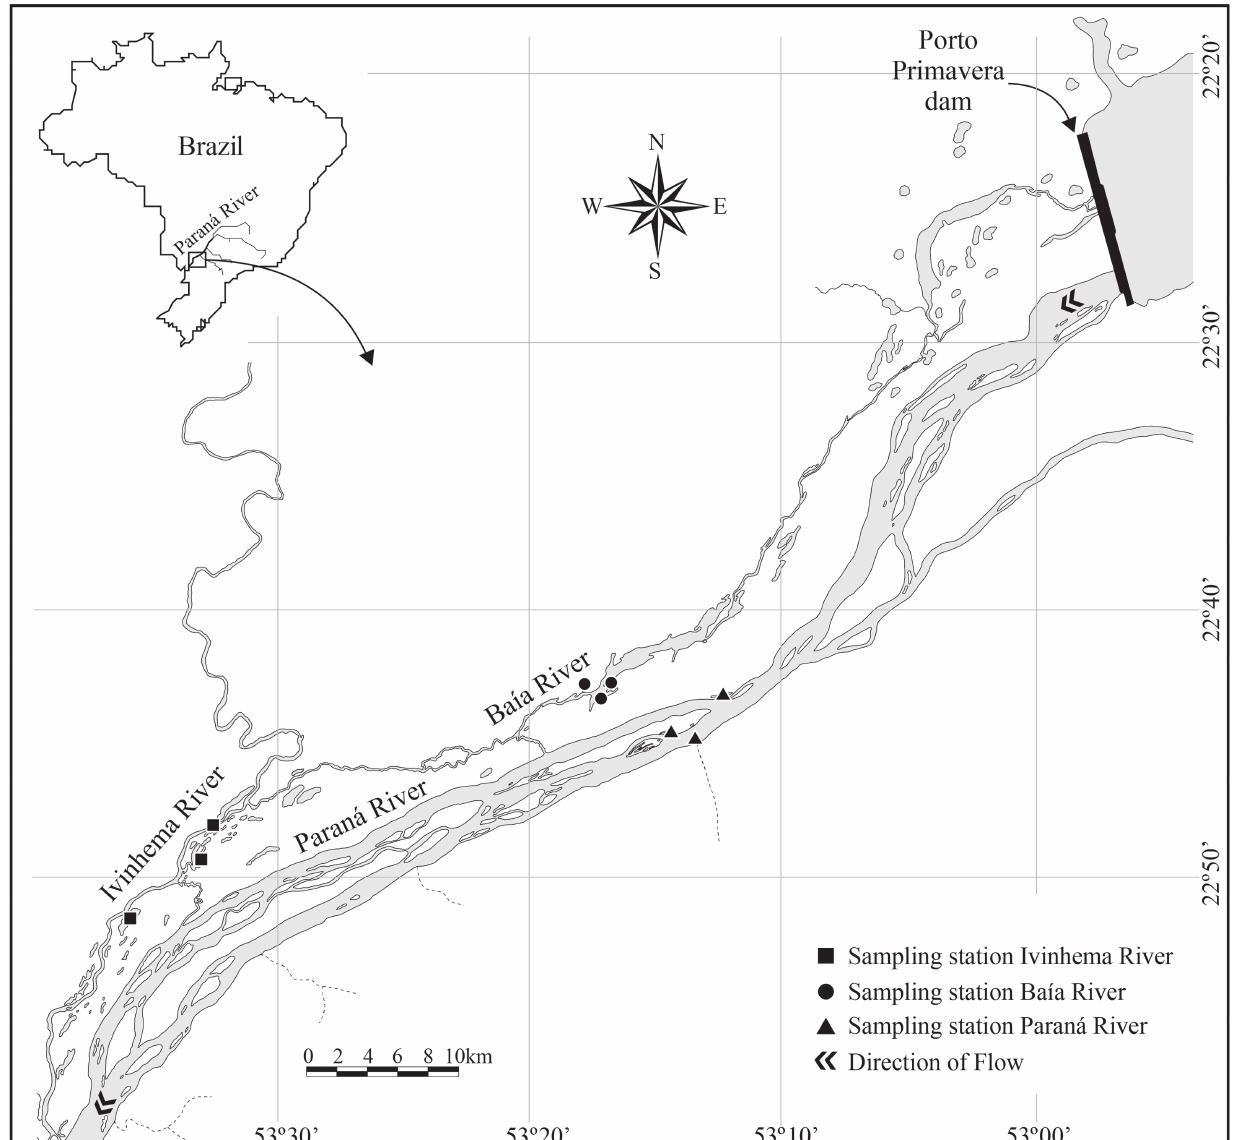
Fig. 1. Map of the Upper Paraná River floodplain. The triangles represent the sampling stations of the Paraná River sub-basin, the circles represent the sampling stations of the Baía River sub-basin, and the squares represent the sampling stations of the Ivinhema River